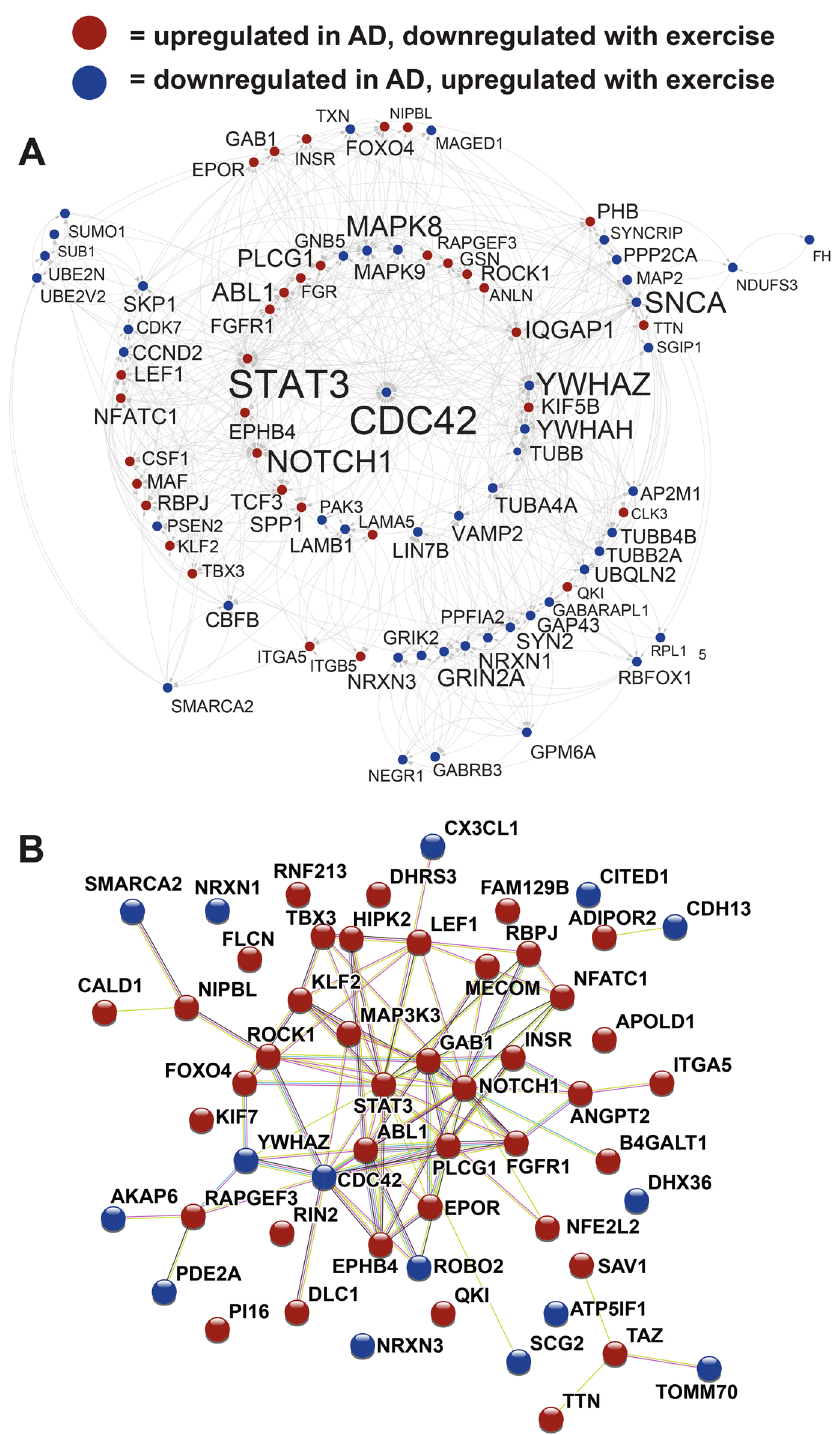
Figure 3. AD dysregulated genes reversed by exercise (human dataset). ( A ) Genes with the highest levels of protein–protein interaction (determined via STRING 15 ) from the 409 AD genes reversed by exercise (top treatment; human high versus low activity) are plotted in Cytoscape 109 . Increased size of font for gene symbol reflects higher number of connections between genes. CDC42, STAT3, NOTCH1, SNCA, YWHAZ, and MAPK8 were among the genes with the most connections. Interactions are highlighted by lines. ( B ) Blood vessel development genes were enriched within the AD genes reversed by exercise and are plotted in STRING 15 . Connections between proteins are shown by lines and color of line indicates type of evidence: light blue (known interactions from curated databases); pink (known interactions that are experimentally determined); green (predicted interactions from gene neighborhood); red (predicted interactions from gene fusions); blue (predicted interactions from gene co-occurrence); light green (text mining); black (co-expression); and gray (protein homology). AD upregulated genes downregulated by exercise are shown in red and AD downregulated genes upregulated by exercise are shown in blue for both ( A,B